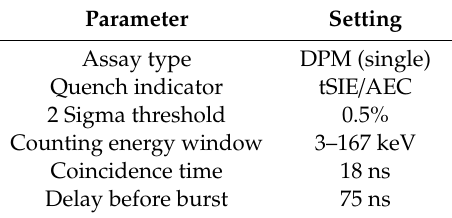
Table 1. Quantulus GCT 6220 settings for counting 35 S in aqueous solution with Hionic-Fluor. Parameter Setting Assay